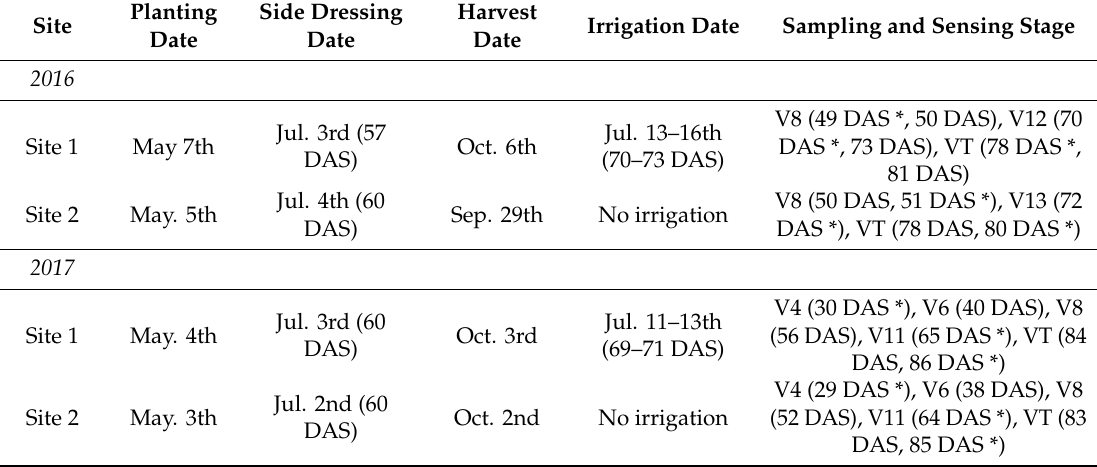
Table 1. Experimental set-up, plant sampling, and sensing stages in the experiment conducted in 2016 and